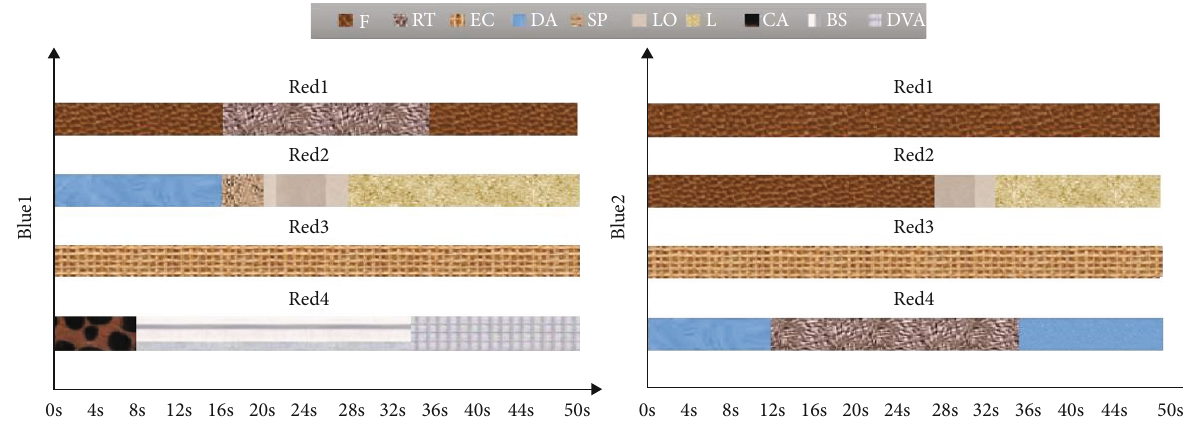
Figure 19: Cooperative tactical intention recognition Figure 15 records the threat assessment values and fea- ture extraction results for the fi rst 40 seconds. In the initial stage of simulation, red3 took blue1 as the target. Halfway